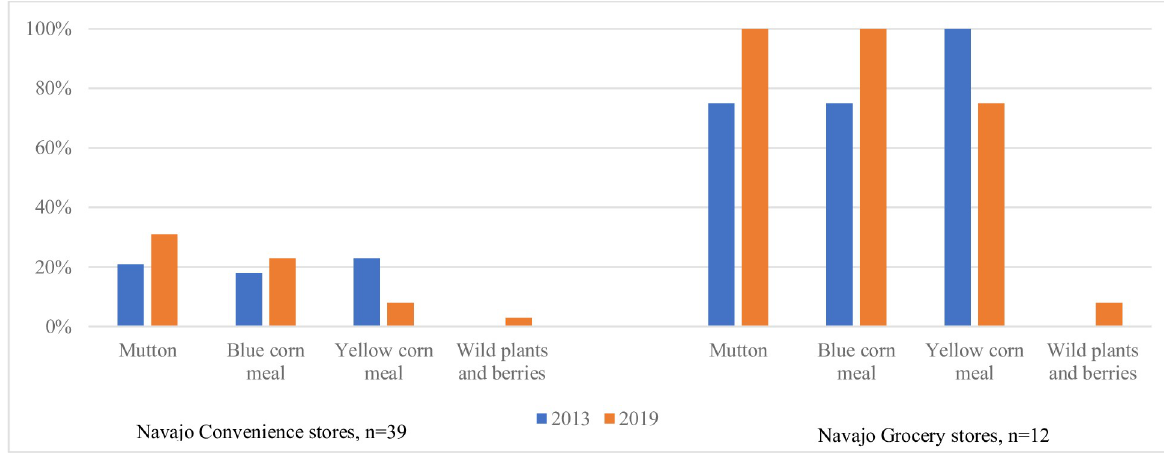
Fig 2. Trends in traditional foods sold in Navajo stores by type, n =